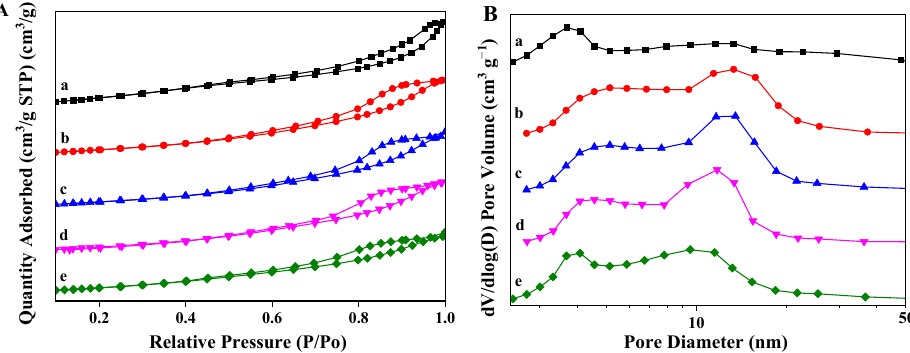
Figure 3. Nitrogen adsorption–desorption isotherms ( A ) and pore-size distribution curves ( B ) of Pt n /Ni 1.5 Co 0.5 AlO catalysts: (a) Ni 1.5 Co 0.5 AlO; (b) Pt 1 /Ni 1.5 Co 0.5 AlO; (c) Pt 2 /Ni 1.5 Co 0.5 AlO; (d) Pt 4 /Ni 1.5 Co 0.5 AlO; (e) Pt 6 /Ni 1.5 Co 0.5 AlO.